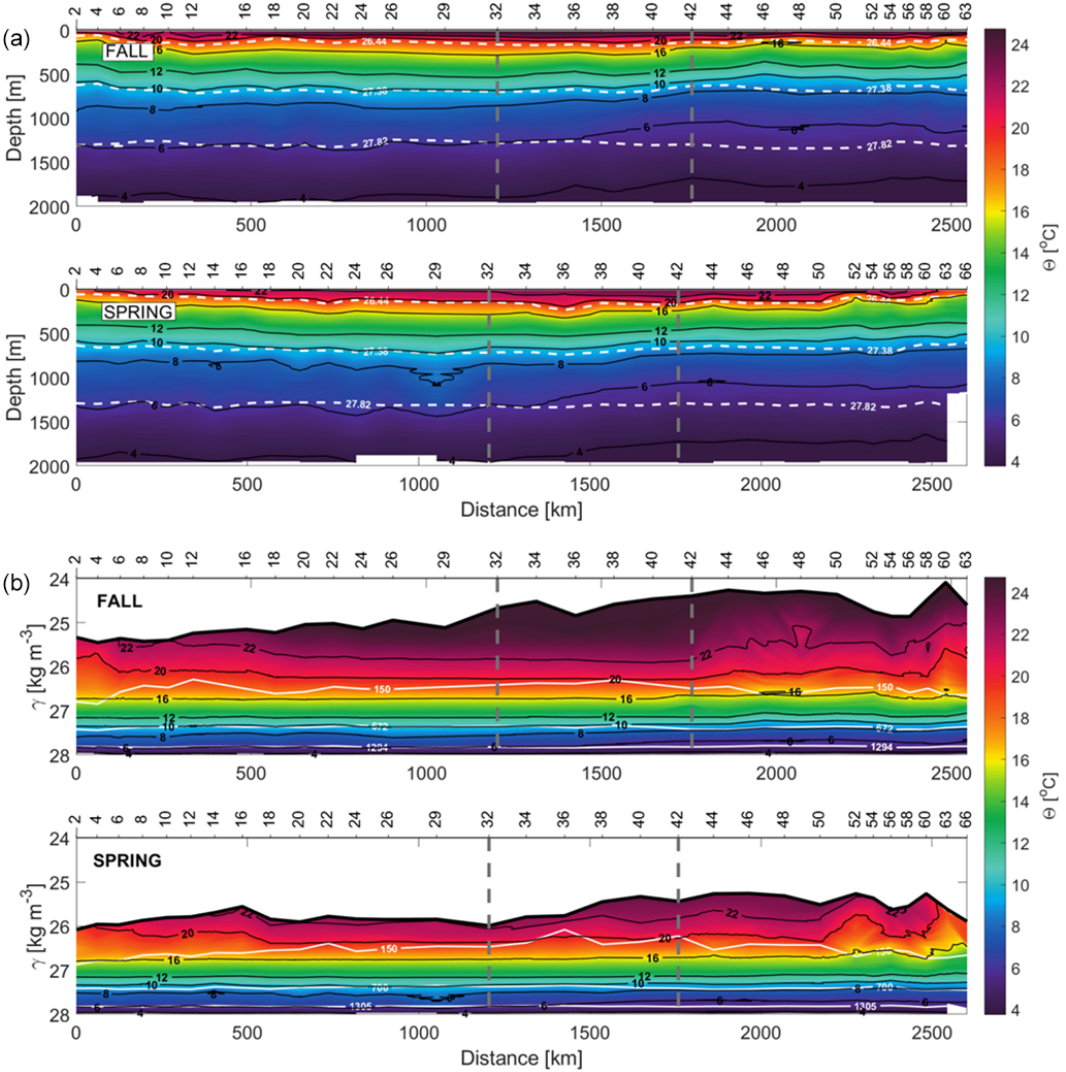
Figure 5. Sections of conservative temperature ( (cid:50) ) with respect to depth (top) and γ n (bottom) during fall and spring. In the depth section in panel (a) , the isoneutrals that delimit the transports at the surface, central, intermediate and deep water in the water column are represented by white dashed contours. In the γ n section (b) , the depths of 150, 672–700 and 1294–1305m are